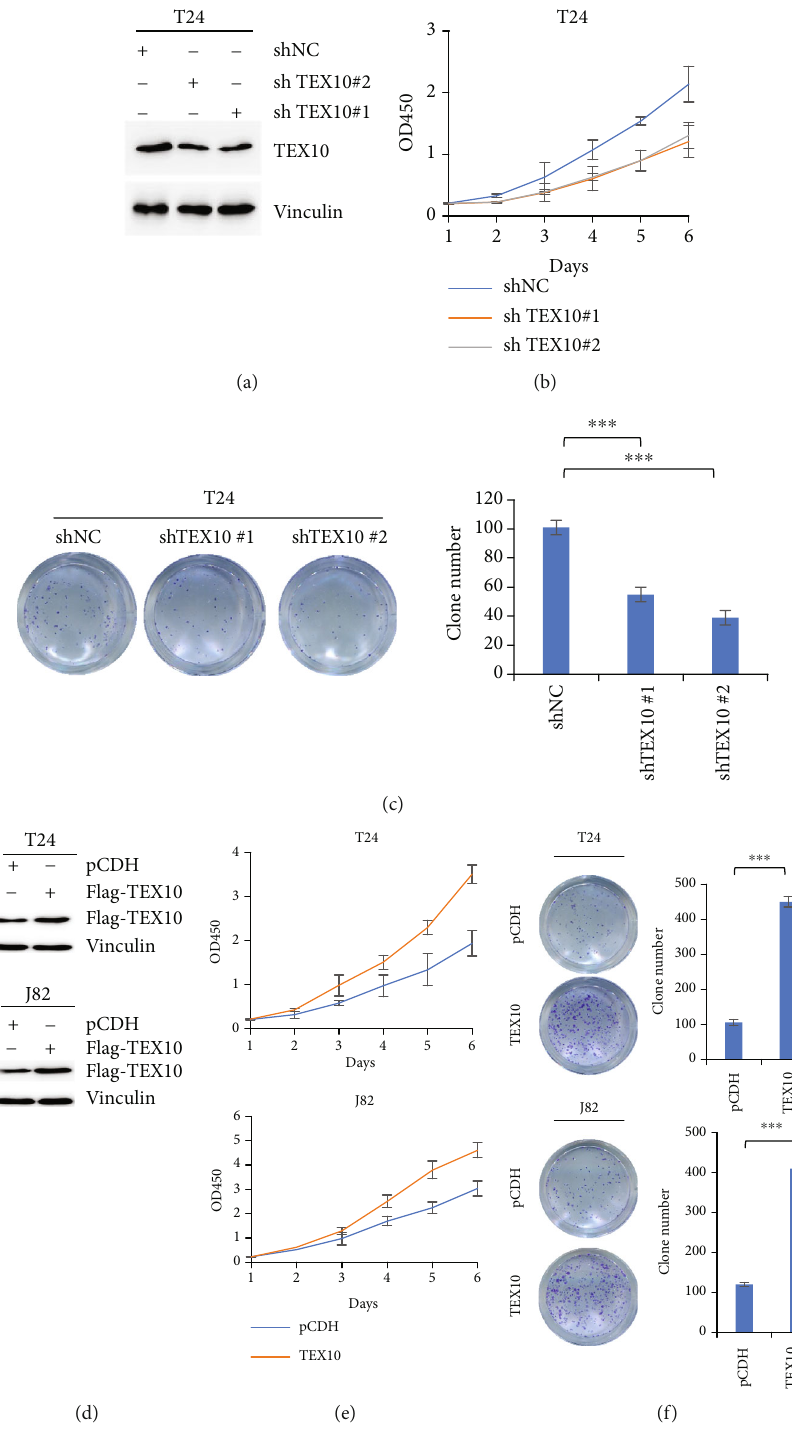
Figure 2: TEX10 promotes urinary bladder carcinoma cell proliferating process in vitro. (a) T24 cells with the steady expression of shNC, shTEX10 #1, and shTEX10 #2 underwent analyzed based on immunoblot using the suggested antibodies. (b) T24 cells with the steady expression of shNC, shTEX10 #1, and shTEX10 #2 underwent cell proliferating tests by CCK8 test. Shown is the mean ± SEM . ∗ P < 0 : 05 ; ∗∗ < 0.01; ∗∗∗ < 0.001, Student ’ s t -test. (c) T24 cells with the steady expression of shNC, shTEX10 #1, and shTEX10 #2 underwent